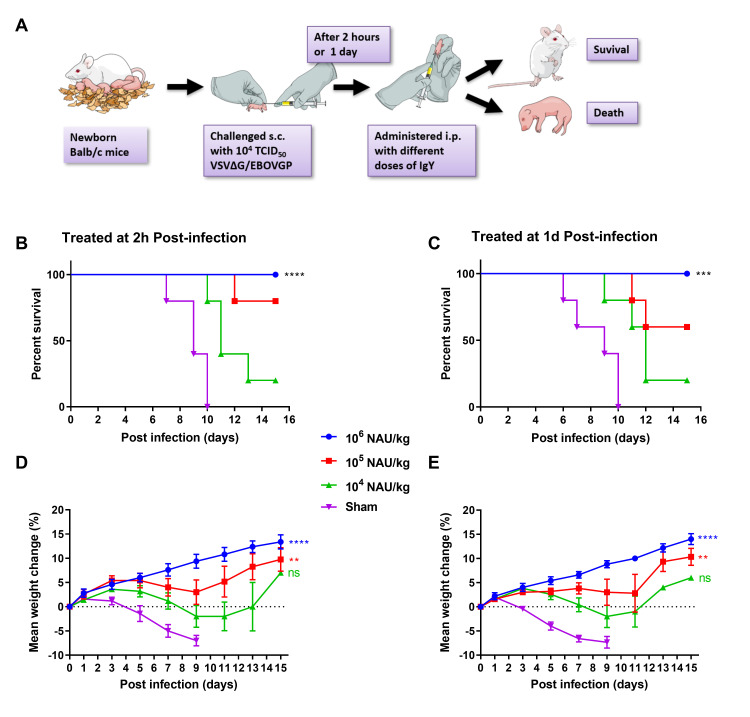
Passive protection of anti-EBOV IgY in newborn Balb/c mice pseudovirus challenge model.Experimental scheme (A). Eight groups of newborn Balb/c mice (3-day-old, n = 5 per group) were challenged s.c. with 104 TCID50 VSVΔG/EBOVGP, after 2 h or 1 day, each mouse was given different doses of IgY or naïve IgY via i.p. route twice daily over 3 days. The survival rates (B, C) and body weight changes (D, E) were monitored and recorded daily. Survival data were analysed by two-sided log-rank test. Weight change was analysed by Tukey–Kramer multiple comparison test. Data are shown as means ± SEM. In all panels with P values: no significant difference (ns) P > 0.05; *P < 0.05; **P < 0.01; ***P < 0.001; ****P < 0.0001.